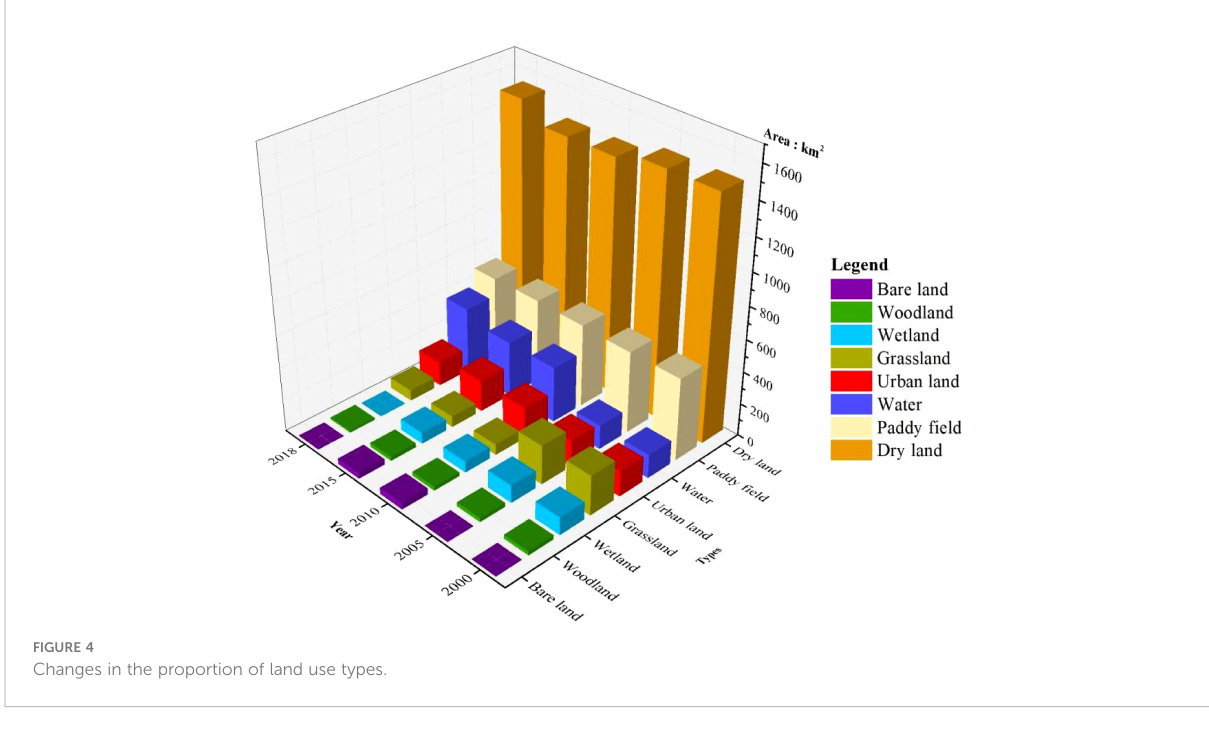
FIGURE 4 Changes in the proportion of land use types.